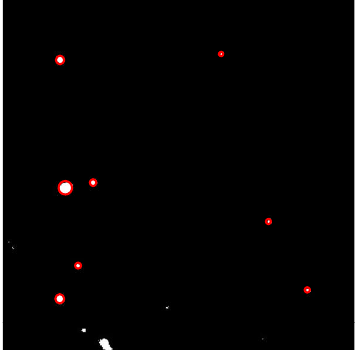
Figure 11. Marking and Highlighting the root feature.